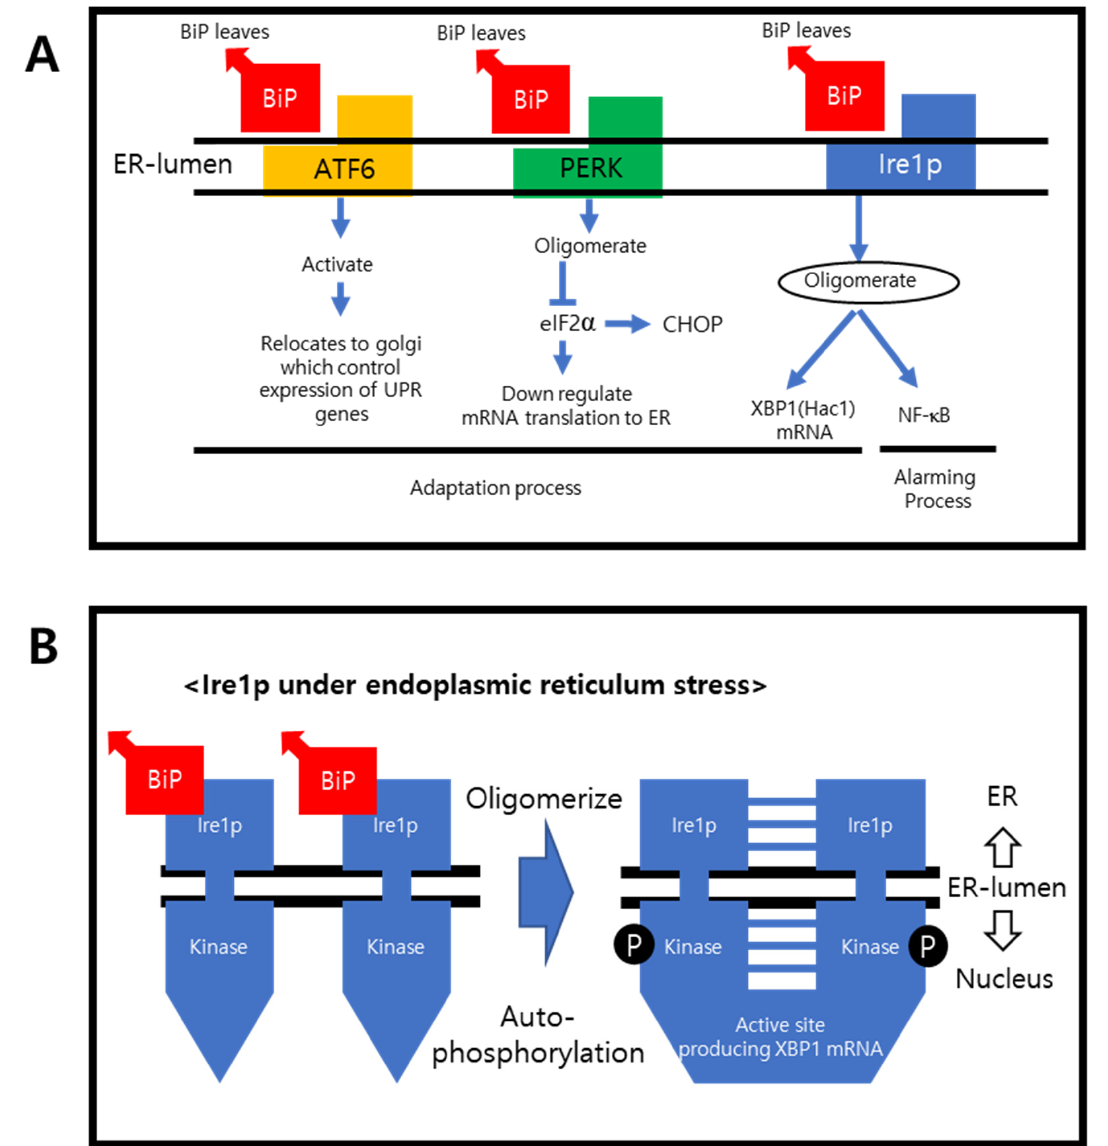
Figure 1. ER stress regulating genes. ( A ) Schematic flow of the transmembrane UPR alarming genes and the process of how they react upon UPR is shown. Upon sensing UPR, BiP leaves, and transmembrane protein phosphorylates and oligomerizes. Then they go through the adaptation process. ( B ) After the BiP leaves the transmembrane proteins, such as Ire1 α , it then oligomerizes on the nucleus side of carboxy terminus, and XBP1 mRNA is activated.